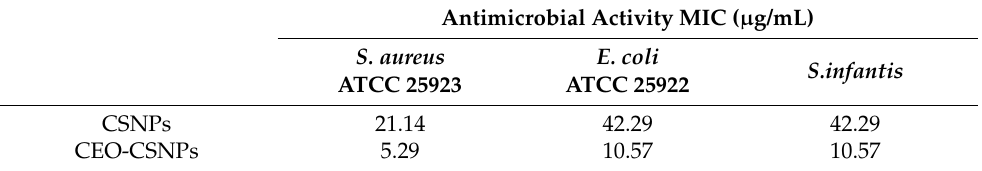
Table 5. Antimicrobial activity of CSNPs and CEO-CSNPs, expressed as minimum inhibitory concen- tration (MIC) against S. aureus , E. coli , and S. infantis